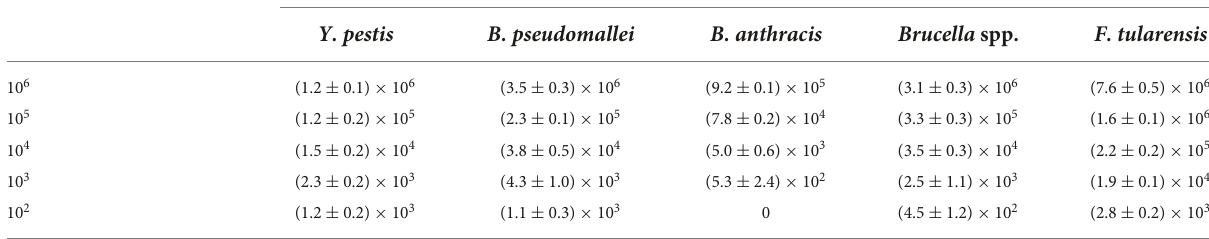
TABLE 2 Estimated bacterial amount of the five selected agents in PBS buffer (CFU/mL) by ddPCR. Amount by plate count